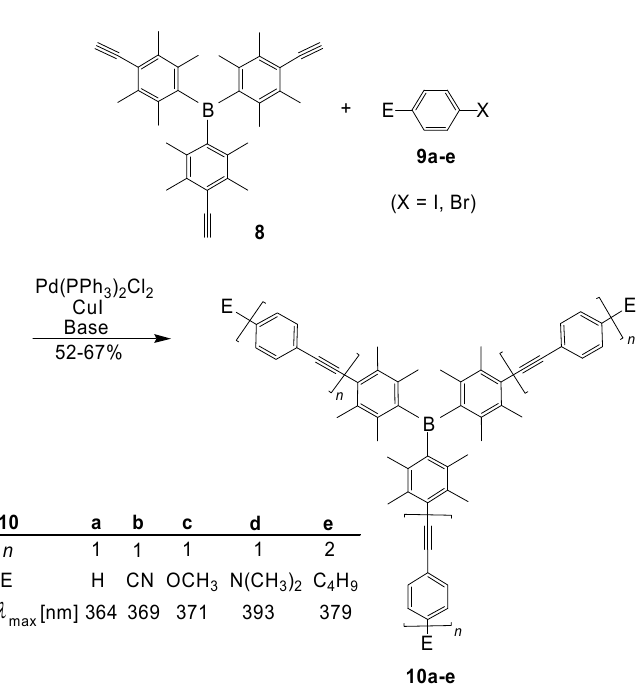
= 530 nm) in DMF (Figure 8). max = 0.16 and 0.54 [43]. F